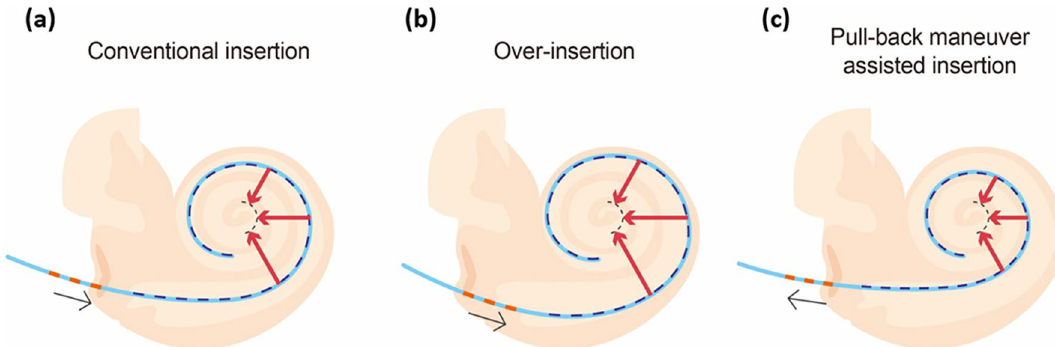
Figure 1. Schematic diagram of the degree of modiolar proximity of the slim modiolar electrode array depending on insertion technique. The slim modiolar electrode array can be advanced or retreated (black arrows) with reference to three white markers of the electrode array and their relationship with the round window. ( a ) Conventional insertion (first white marker), ( b ) over-insertion (up to third white marker), and ( c ) pull-back maneuver assisted insertion (first white marker). Red arrows indicate the distance between modiolus (dotted black line) and electrode array, reflecting the degree of modiolar